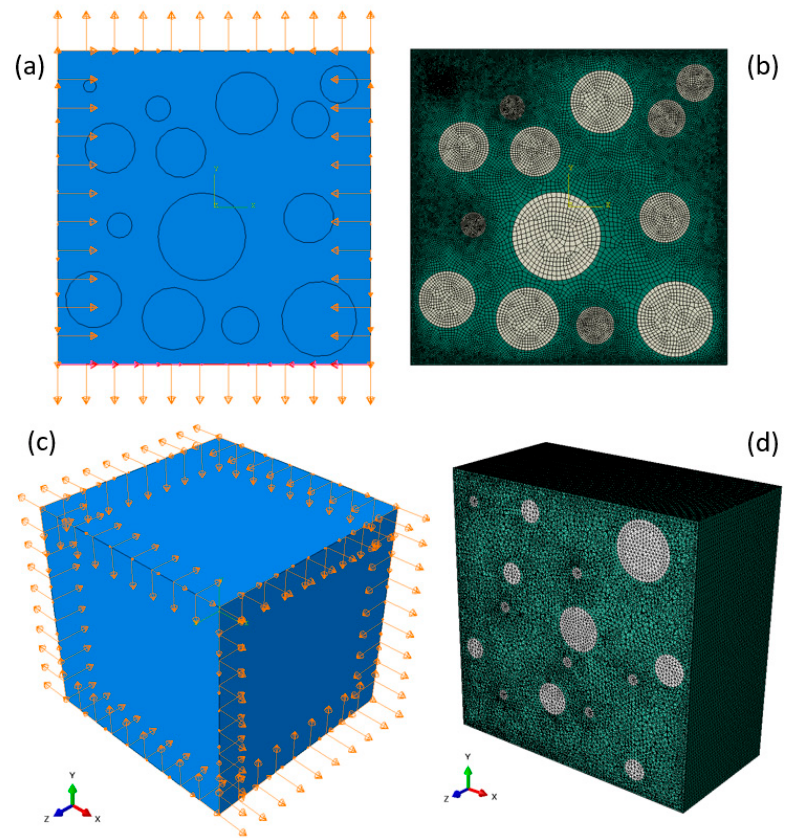
Figure 3. Representative boundary conditions and mesh for ( a , b ) 30% particle volume fraction under pure tension loading in a RAE unit cell and ( c , d ) 10% particle volume fraction under pure tension loading in a RVE unit cell. ( d ) Cut view in the middle of the RVE.